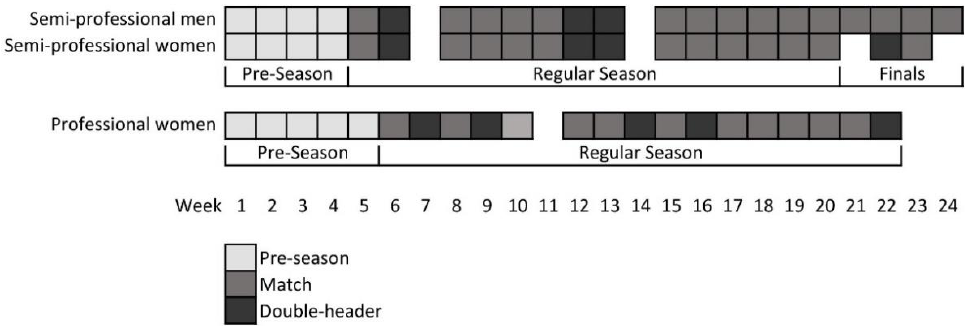
Figure 1. Schematic of the season timelines.